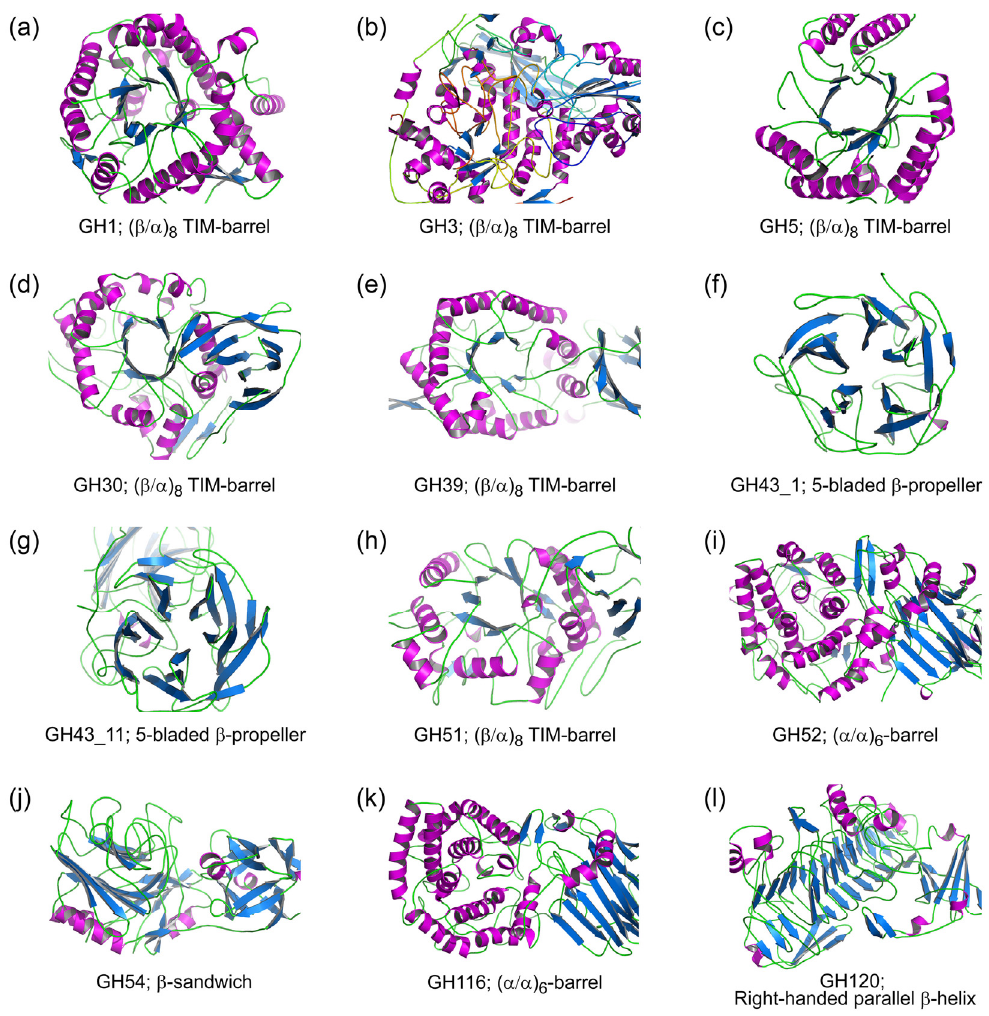
Figure 2. Three-dimensional (3D) structures of β -xylosidases from various GH families. Helix, strand, and loop structures are colored in magenta, blue, and green, respectively. GH family numbers and fold type of their catalytic domains are shown. The structures represented are ( a ) RfBGluc-1 from Reticulitermes flavipes (GenPept ADK12988); ( b ) GlyA1 from metagenomic cow rumen fluid (PDB 5K6L); ( c ) PcXyl5 from Phanerochaete chrysosporium BKM-F-1767 (GenPept AHL69750) ( d ) PiBGX1 from Phytophthora infestans (GenPept AAK19754); ( e ) TsXynB from Thermoanaerobacterium saccharolyticum B6A-RI (PDB 1PX8); ( f ) RS223-BX from an uncultured organism (PDB 4MLG); ( g ) GsXynB3 from Geobacillus stearothermophilus T-6 (PDB 2EXH); ( h ) AtAraf from Arabidopsis thaliana (GenPept AAF19575); ( i ) GT2_24_00240 from Geobacillus thermoglucosidasius TM242 (PDB 4C1O); ( j ) TkAbf from Trichoderma koningii G-39 (GenPept AAA81024); ( k ) SSO1353 from Saccharolobus solfataricus P2 (GenPept AAK41589); and ( l ) TsXylC from Thermoanaerobacterium saccharolyticum JW / SL-YS485 (PDB 3VST). The structures of (a), (c), (d), (h), (j), and (k) were modeled using PDB entries 3VIK, 1EQP, 2XWE, 2C8N, 1WD3, and 5BVU, respectively, which belong to the same GH family but do not have β -xylosidase activity.